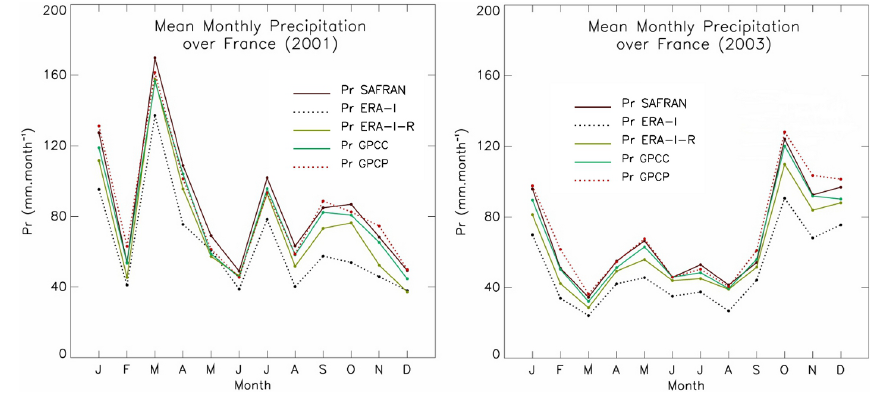
Fig. 4. Mean monthly precipitation over France for SAFRAN, ERA-I, ERA-I-R, GPCC and GPCP: (left) 2001, and (right) 2003.